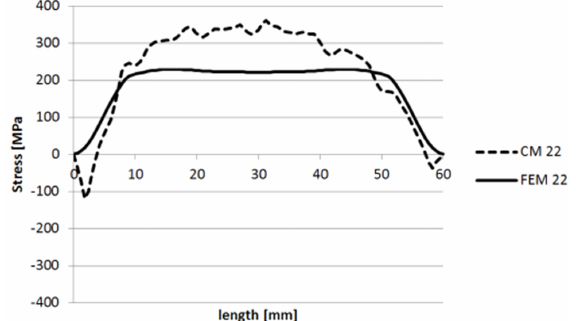
Figure 27. Stress levels in 22 direction along the AB line segment.